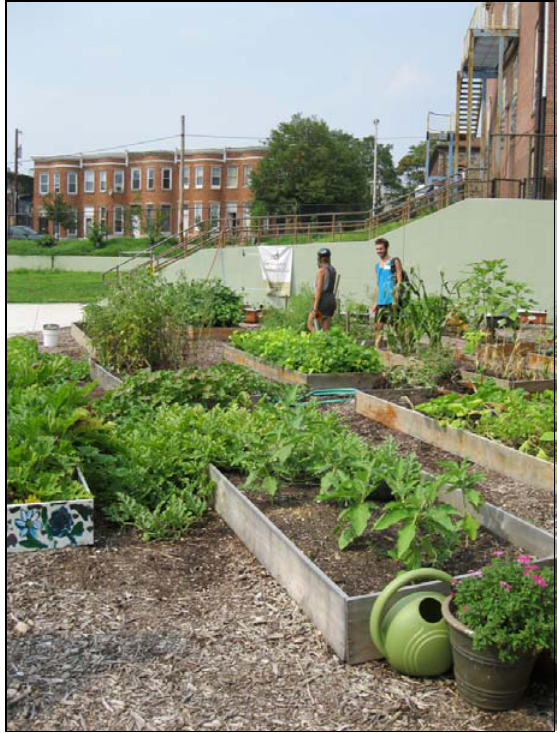
Figure B. The Baltimore Montessori Public Charter